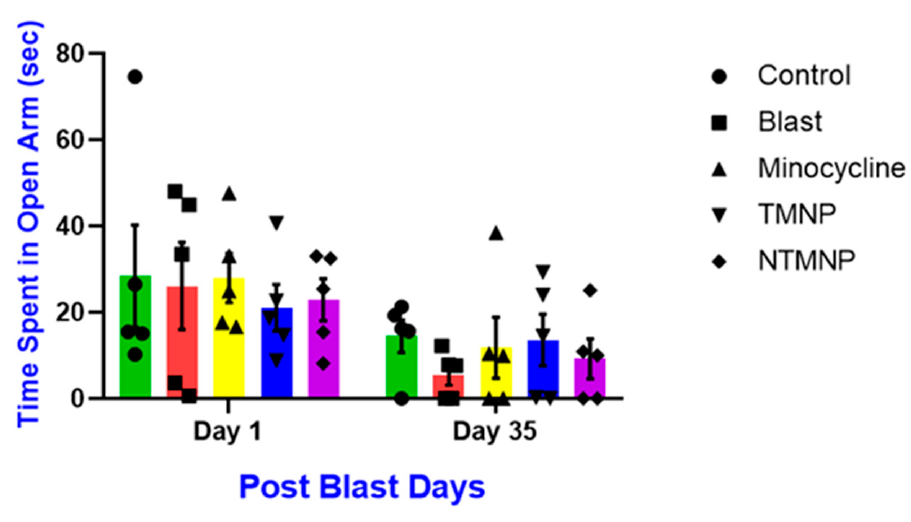
Figure 10. Free minocycline, targeted (TMNP), and non-targeted minocycline (NTMNP) nanoparticles reduced moderate blast-induced anxiety.